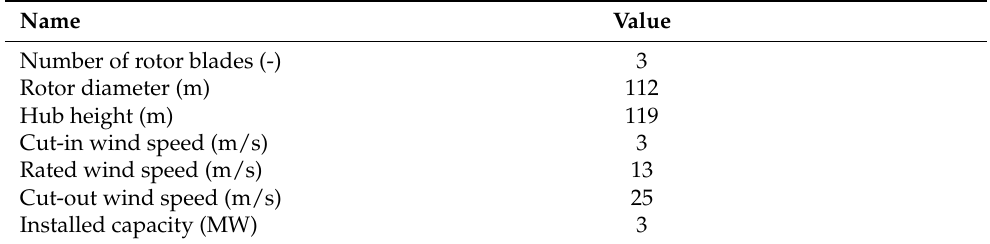
Figure 1. ( a ) Map with the location of the wind turbine and the measurement instruments (map based on data provided by Swisstopo). ( b ) Picture of the wind turbine showing the locations of the radar instrument and total stations. Table 1. The main characteristics of the Vestas V112-3.0 MW wind turbine